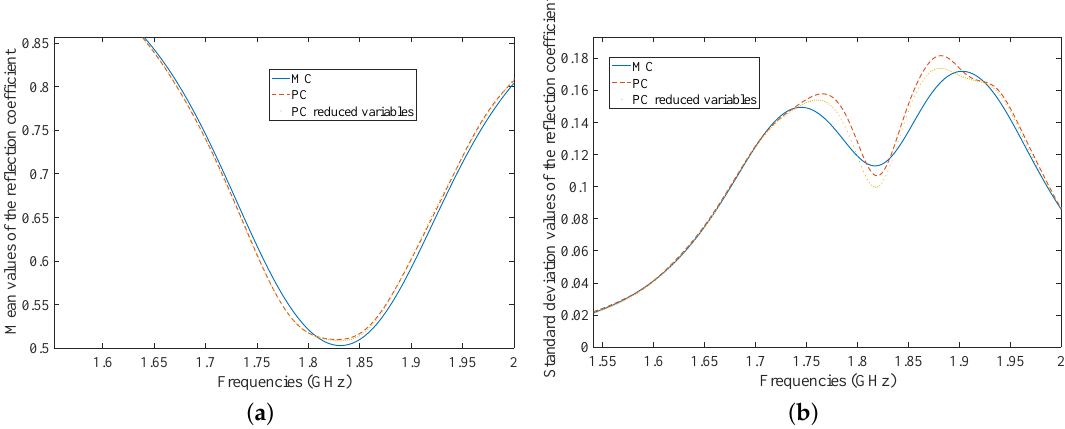
Figure 12. ( a ) Mean value and ( b ) standard deviation of the reflection coefficient for the second case of the path-antenna